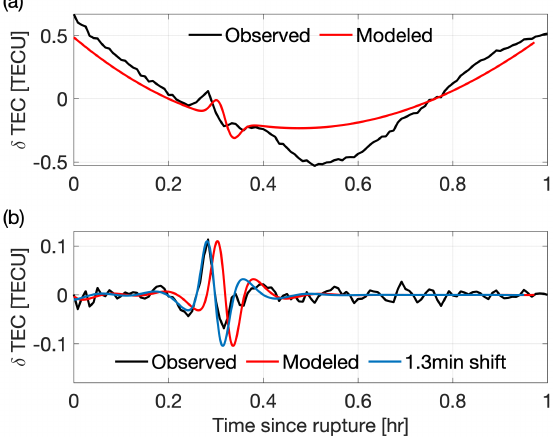
Figure 3. Observed and modeled sTEC at station BTNG for GPS satellite 21: ( a ) sTEC after linear detrend from 0 to 1 h; and ( b ) perturbation signal after bandpass filtering ( a ) from 2 to 13 mHz, including the modeled time series after a 1.3 min